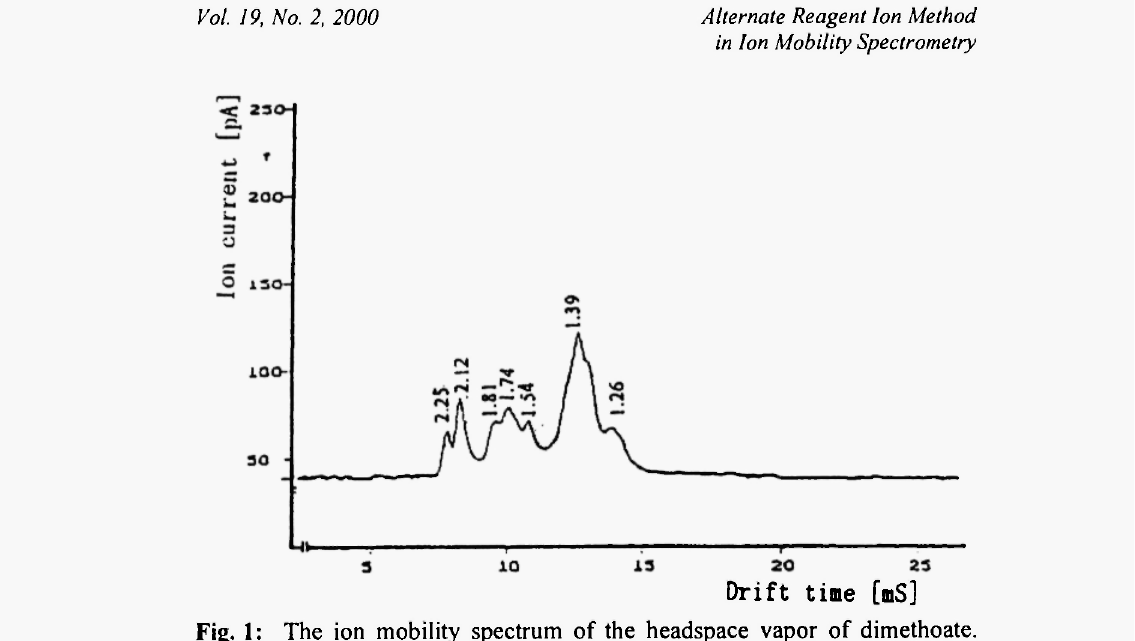
Fig. 1: The ion mobility spectrum of the headspace vapor of dimethoate. (Peaks at 2.25 and 2.12 cm 2 V''s'' are the reactant ions and 1.74 may be the peak of benzene, 1.81 is the peak of methylbenzene, 1.39 may be the peak of dimethylbenzene, 1.54 may be the peak of the monomer ion of dimethoate, and 1.26 is the protonated dimer ion peak of